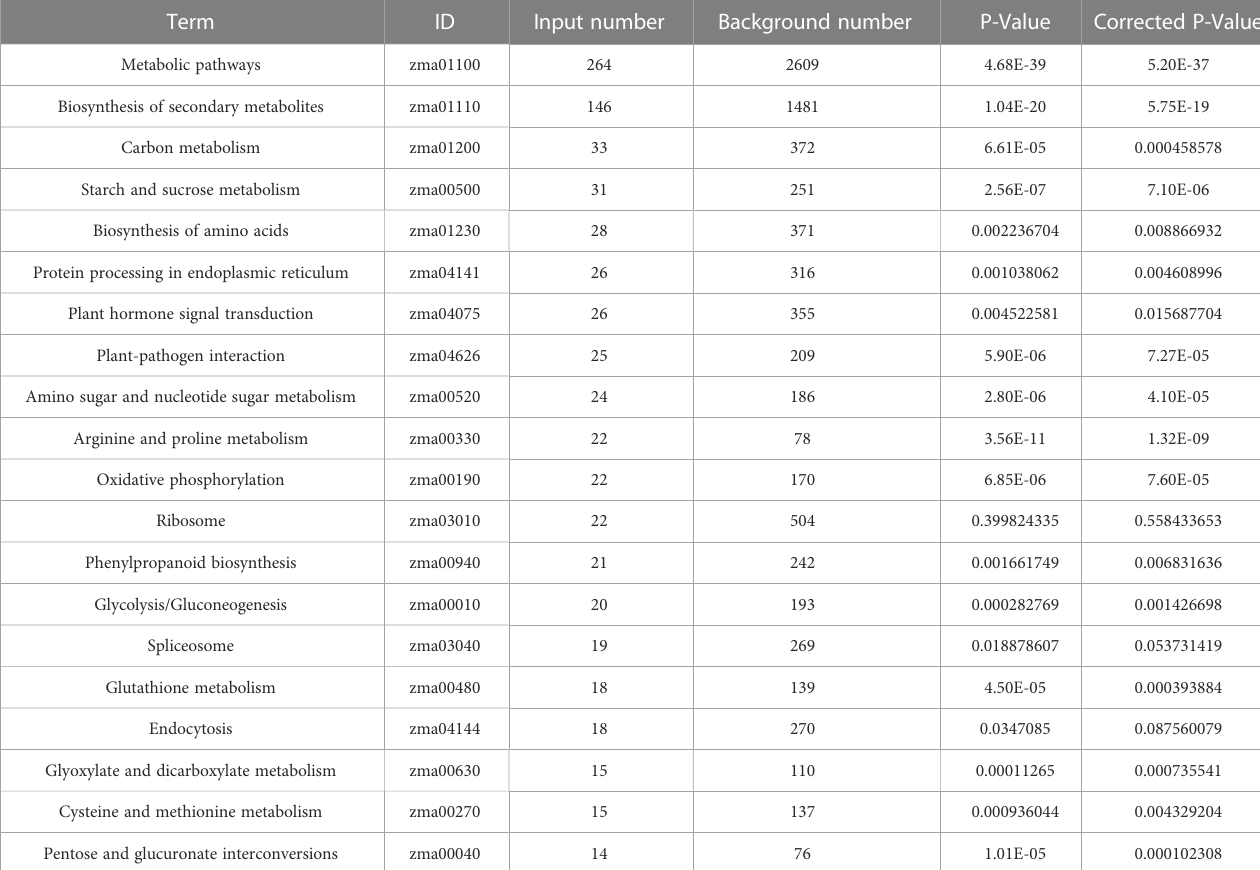
TABLE 4 Top twenty KEGG pathway enrichment of the DEGs of leaf, pollen and ovule under heat stress